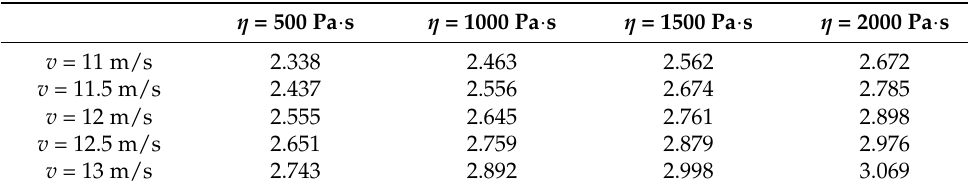
Table 5. Comparison of the surface wave amplitudes.